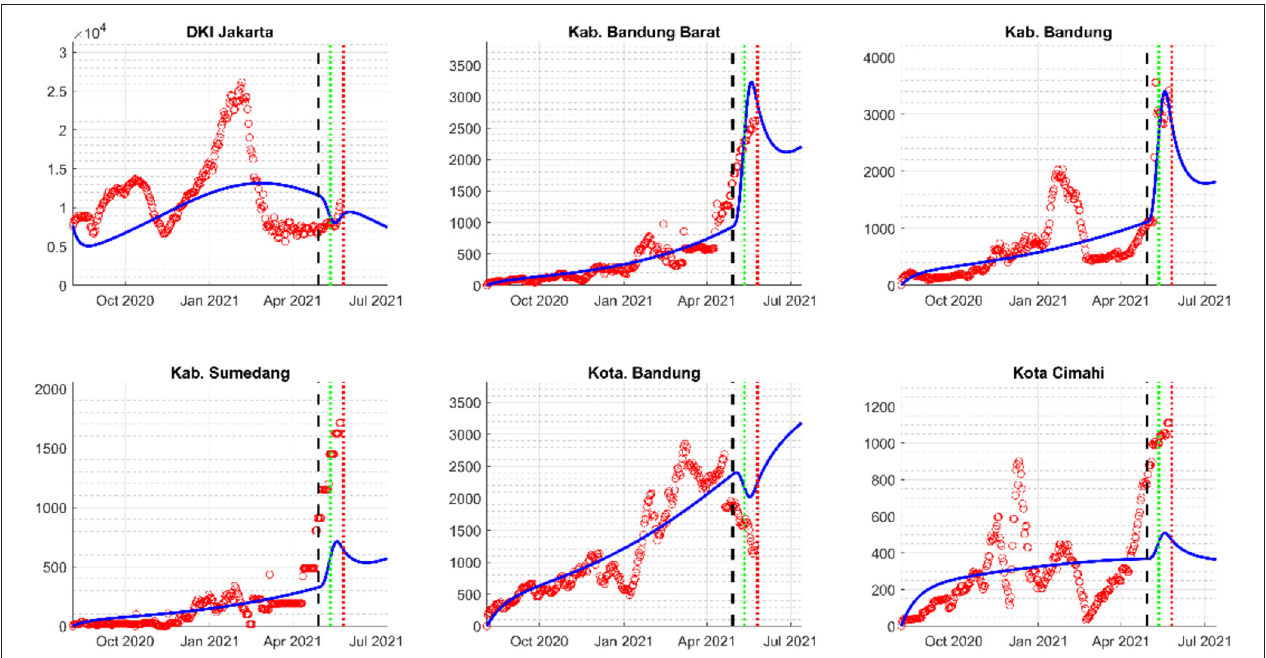
FIGURE 7 | Comparison of the actual data and the rendered model in Jabaraya during the mass exodus of